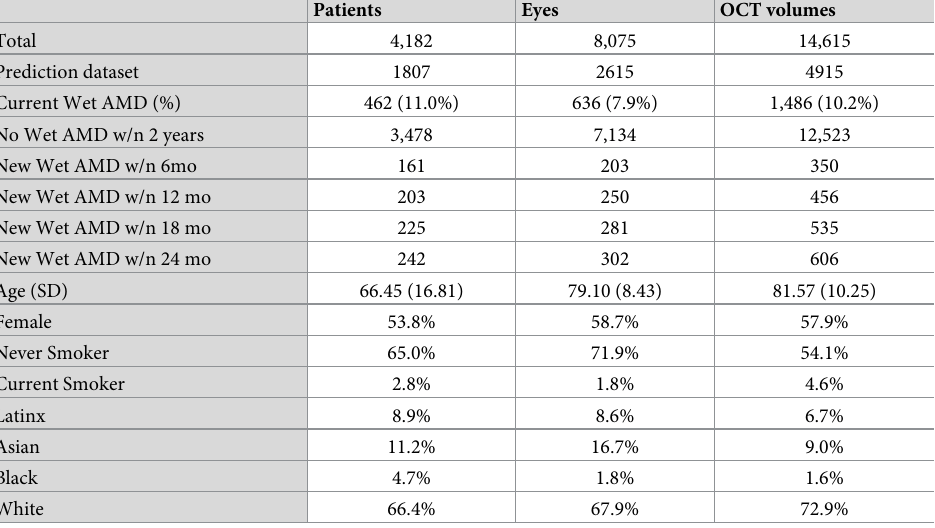
Table 5. Descriptive statistics of the